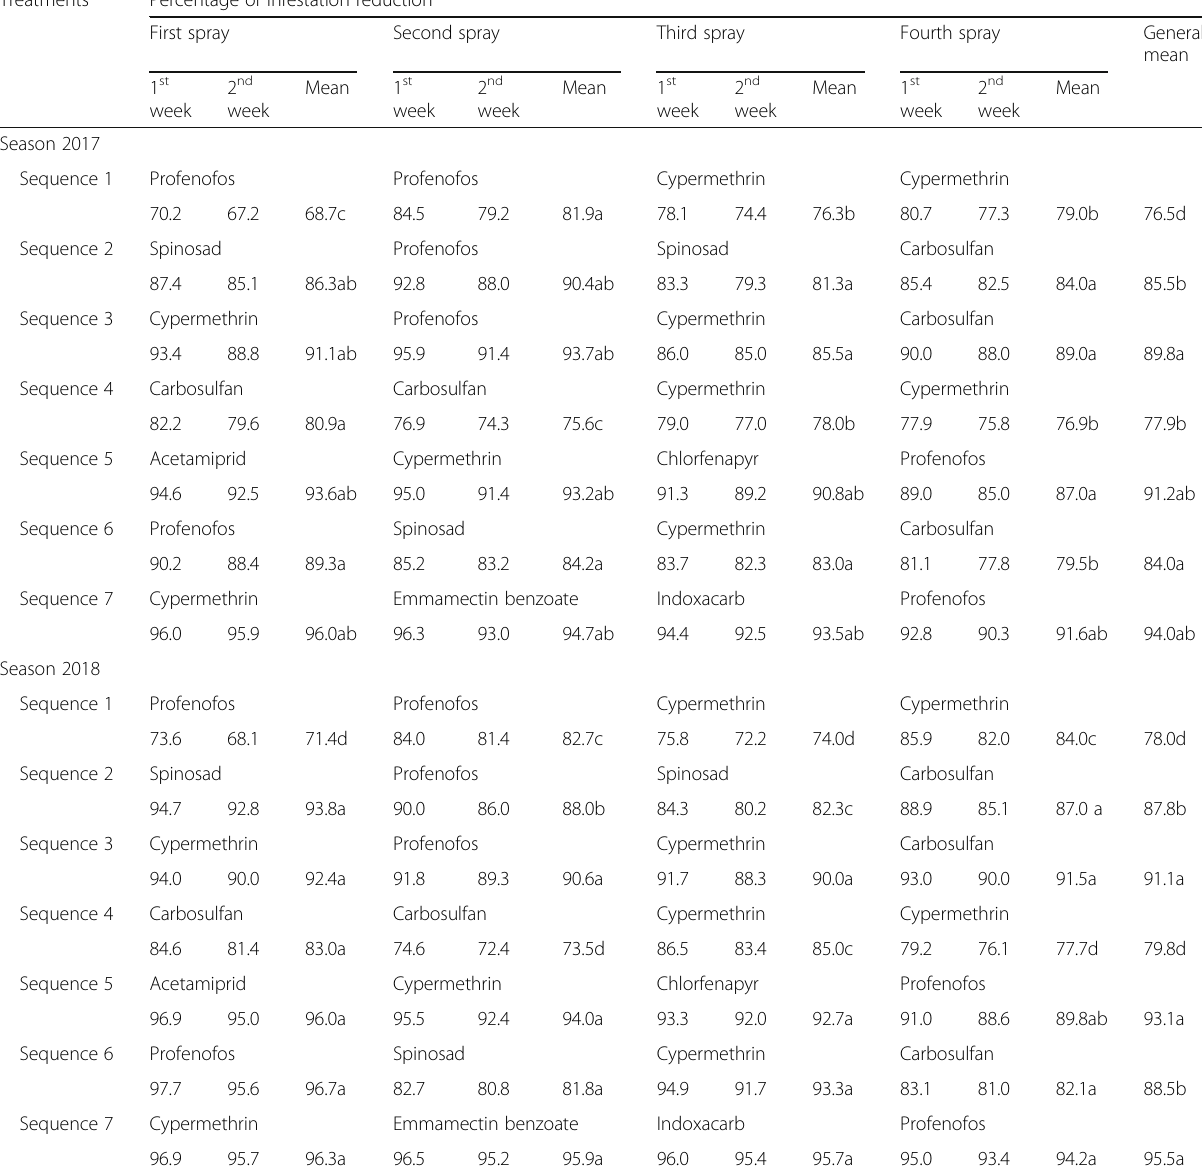
Table 3 Infestation reduction percentage of Earias insulana during two seasons